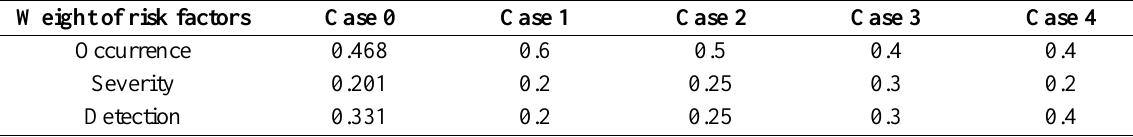
Table 8. Weights of risk factors corresponding to the hypothetical case